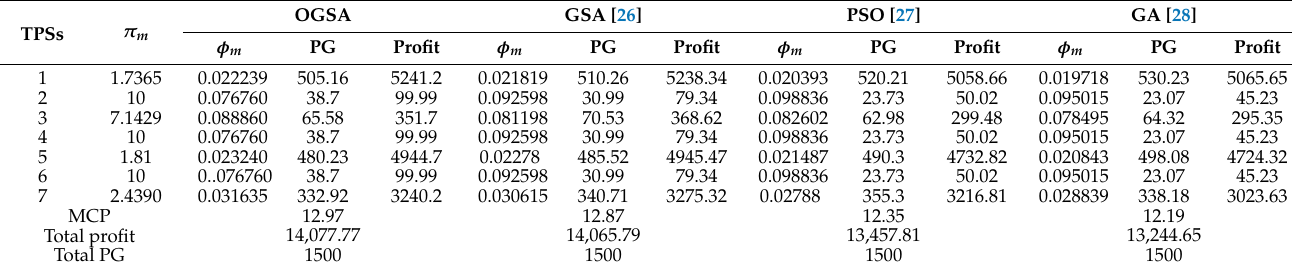
Table 5. Findings for the IEEE standard 57-bus exclusive of renewable influence.